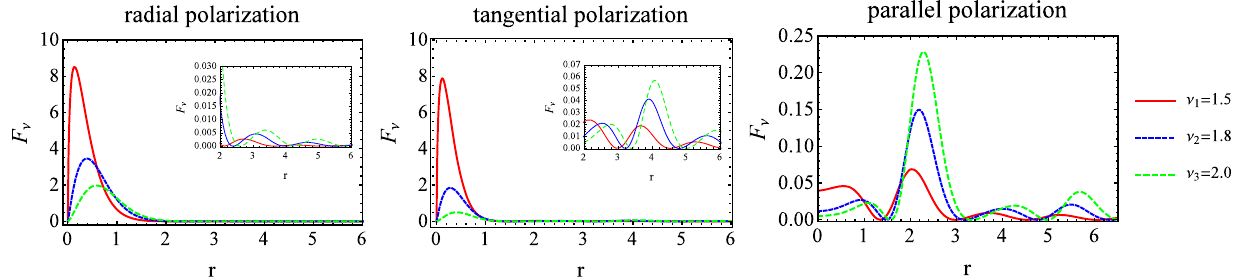
Fig. 5 QFI of the deficit angle parameter ν as a function of the effec- effective time τ = 4 and the initial state parameter θ = 0. Here F ν tive distance r with fixed values of the parameter ν = 1 . 5 , 1 . 8 , 2 . 0. The and ν are dimensionless. θ is the state parameter, which is expressed in left to right panels correspond to the radial polarization (ζ r ,ζ α ,ζ z ) = radian. τ and r are also dimensionless by rescaling, actually r is in the ( 1 , 0 , 0 ) , the tangential polarization (ζ ,ζ α ,ζ ) = ( 0 , 1 , 0 ) and the unit of c ω , and τ is in the unit of 1 γ r z 0 parallel polarization (ζ r ,ζ α ,ζ z ) = ( 0 , 0 , 1 ) , respectively. We take the